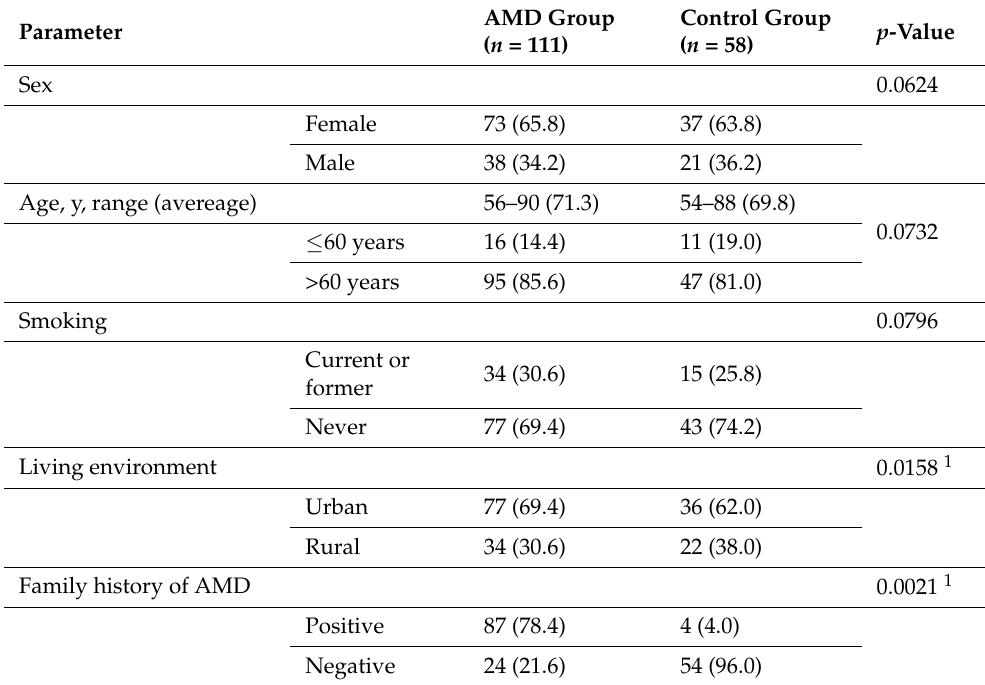
Table 1. Characteristics of patients with age-related macular degeneration (AMD) and controls.